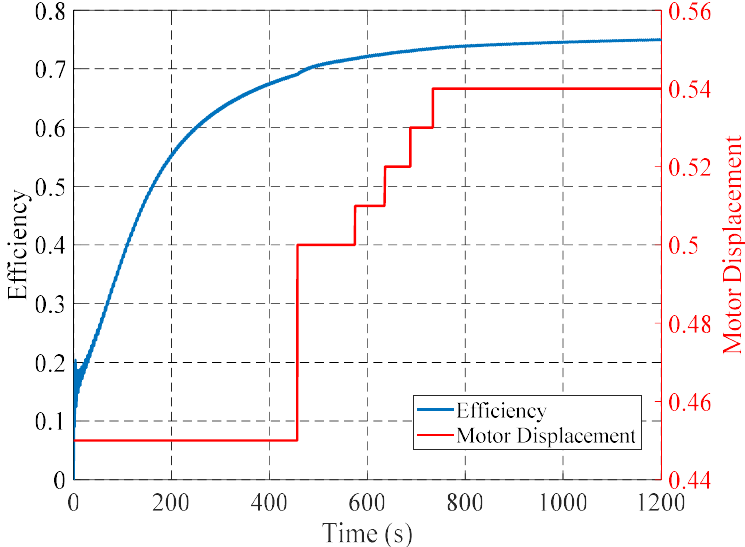
Figure 20. The efficiency of hydraulic PTO under the MPPT control.